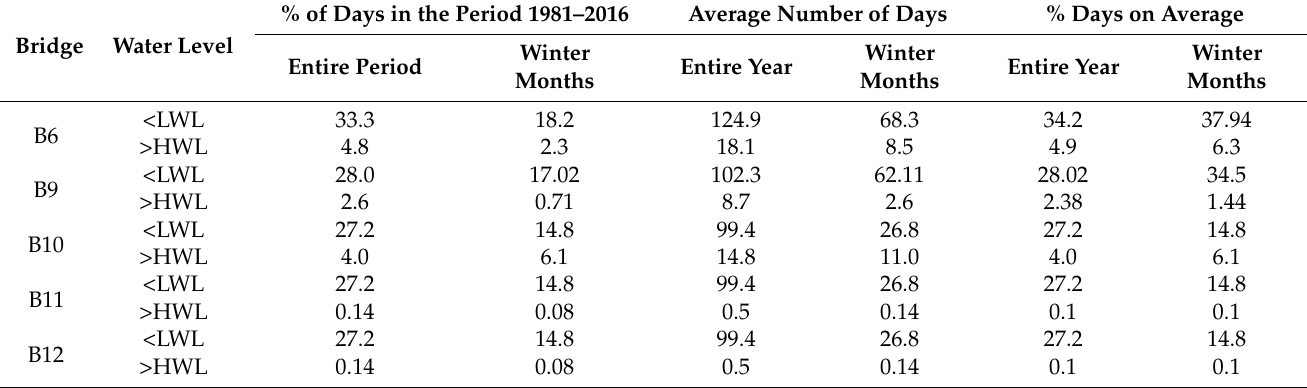
Table 4. Probability of water level HWL exceeding frequency and possibility of lower water levels (LWL) in cross sections of the Vistula waterway between 1981–2016. The analysis was carried out annually and only for winter (November–April).